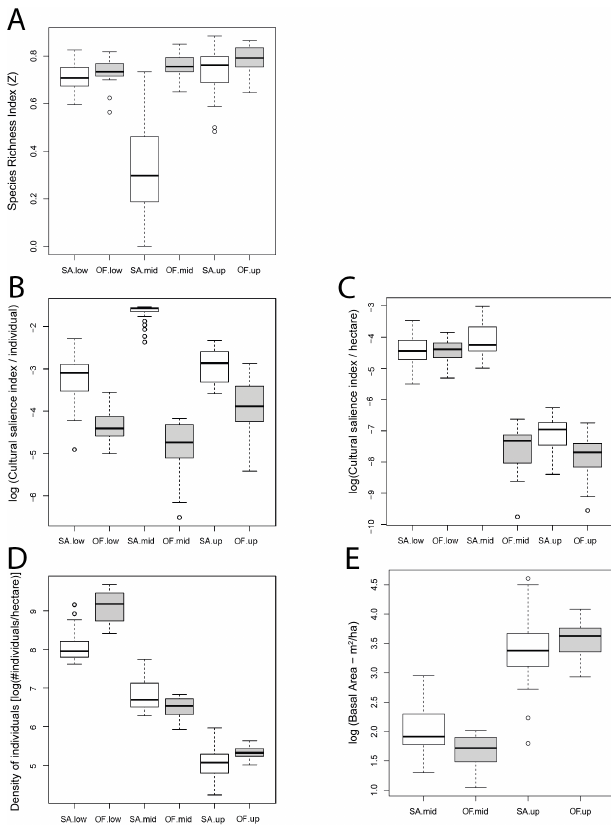
Fig. 3 . Boxplots showing comparisons between sacred agroforests (SA, white boxes) and old fallows (OF, grey boxes) regarding (A) species richness index (Sheil et al. 1999), cultural salience index [per individual (B) and per hectare (C)], density of individuals (D), and basal area (E) for three vegetation strata: lower (“low”), middle (“mid”) and upper (“up”). For our definition of the species richness index, the cultural salience index, and the vegetation strata see section “Case study and